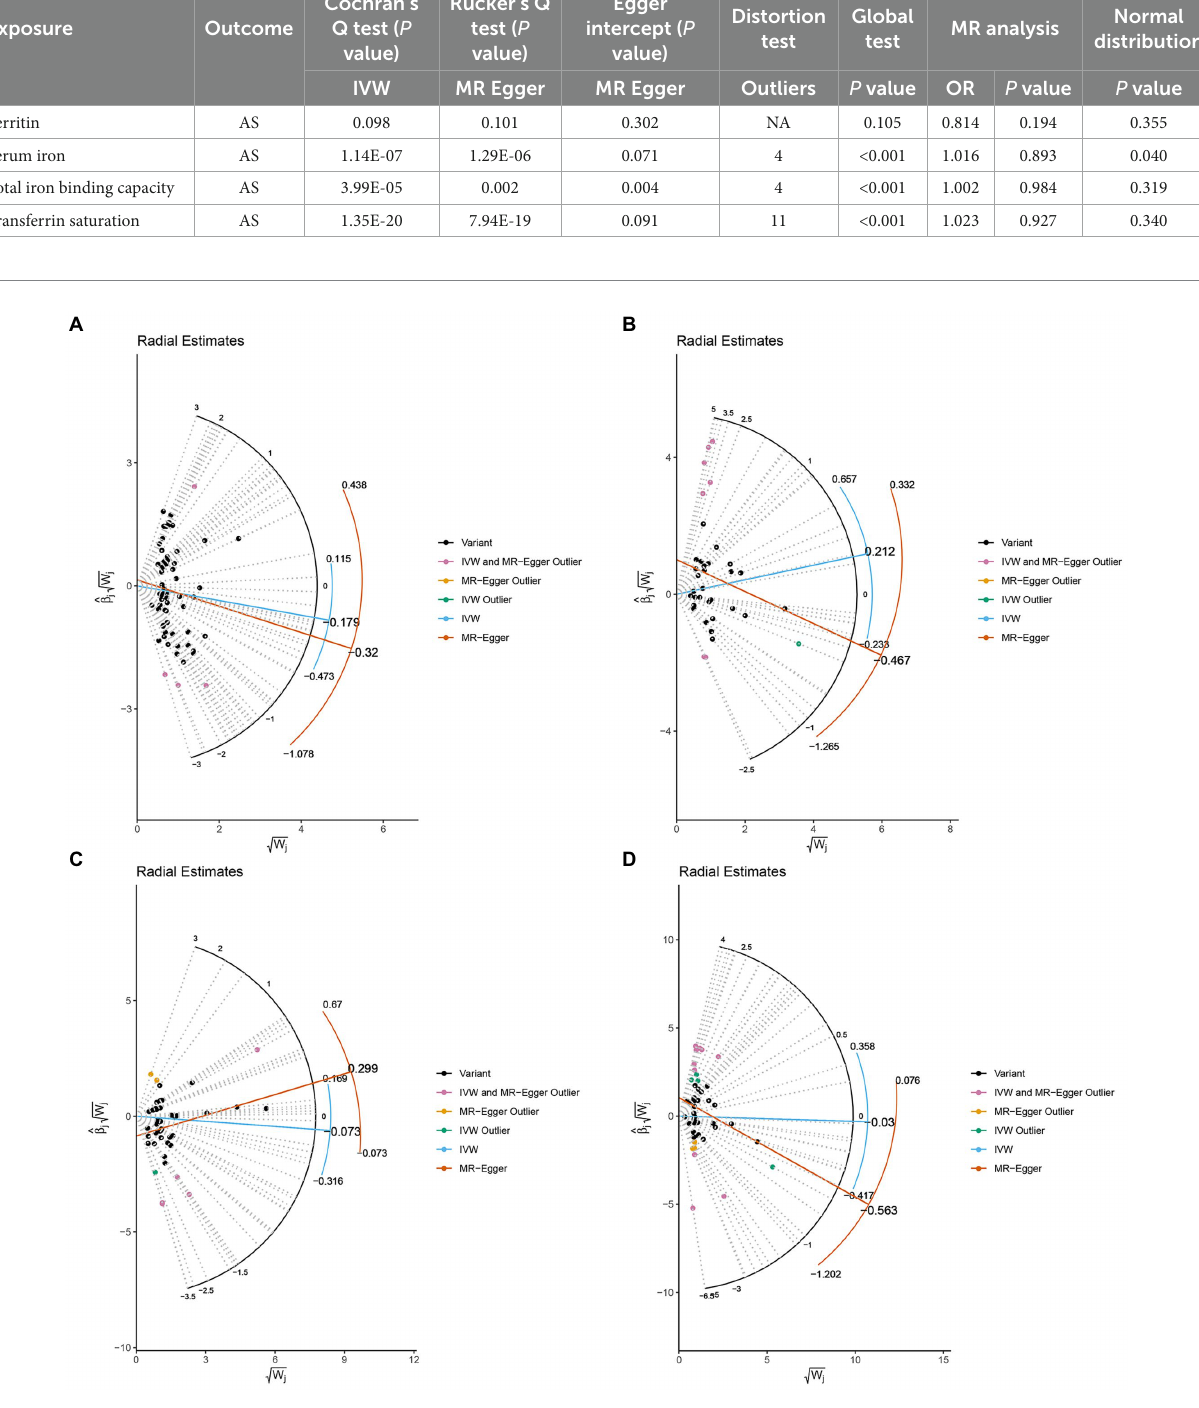
confounding factors and eliminated heterogeneity and horizontal pleiotropy in the MR analysis. Therefore, our results were robust and satisfied the three assumptions of MR.